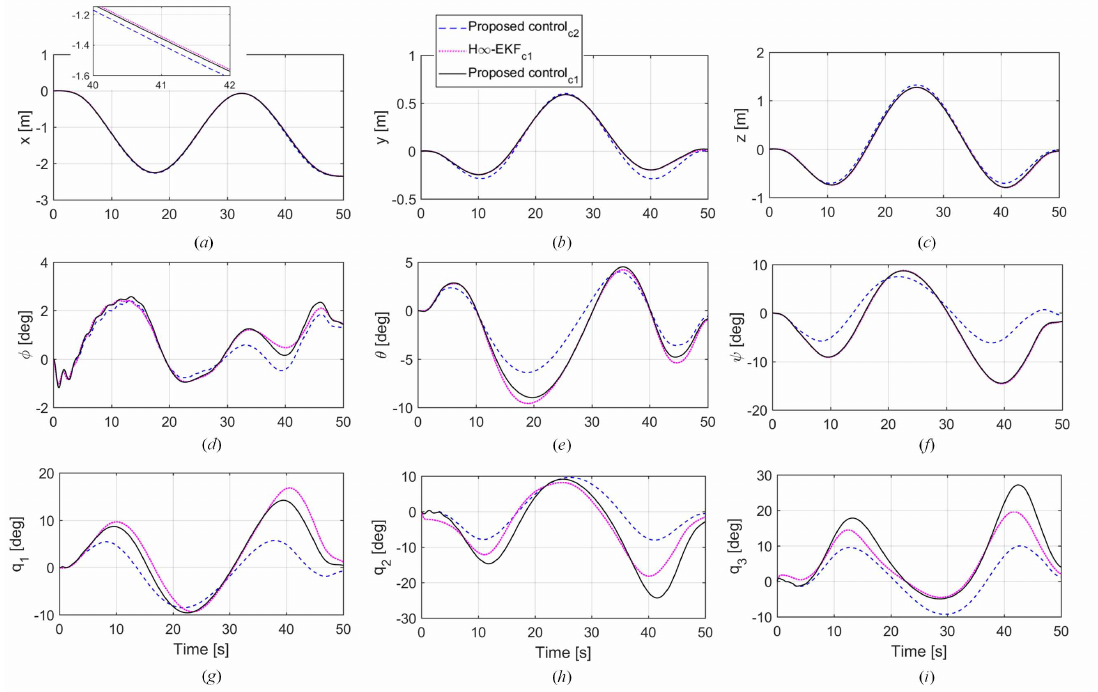
Figure 11. Joint-space positions for the circular trajectory. ( a ) X position, ( b ) y position, ( c ) z position, ( d ) roll angle, ( e ) pitch angle, ( f ) yaw angle, ( g ) joint 1 angle, ( h ) joint 2 angle, ( i ) joint 3